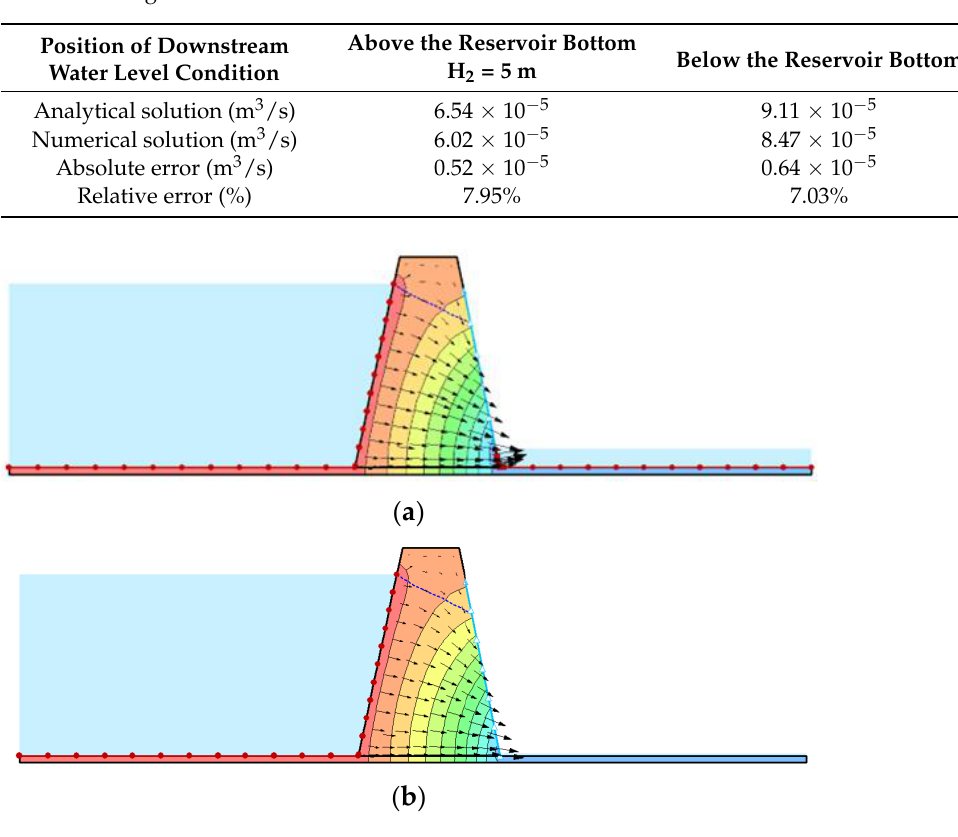
Table 2. Leakage from the core.